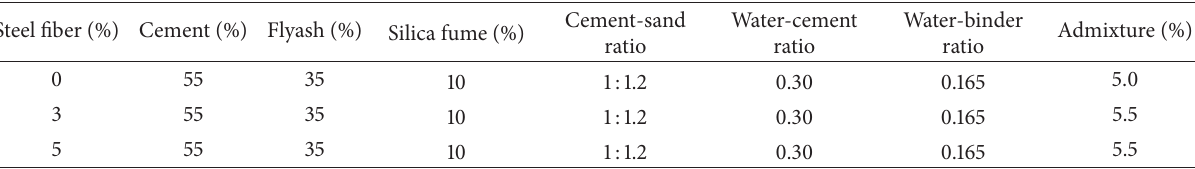
Table 1: The mix proportion of concrete.